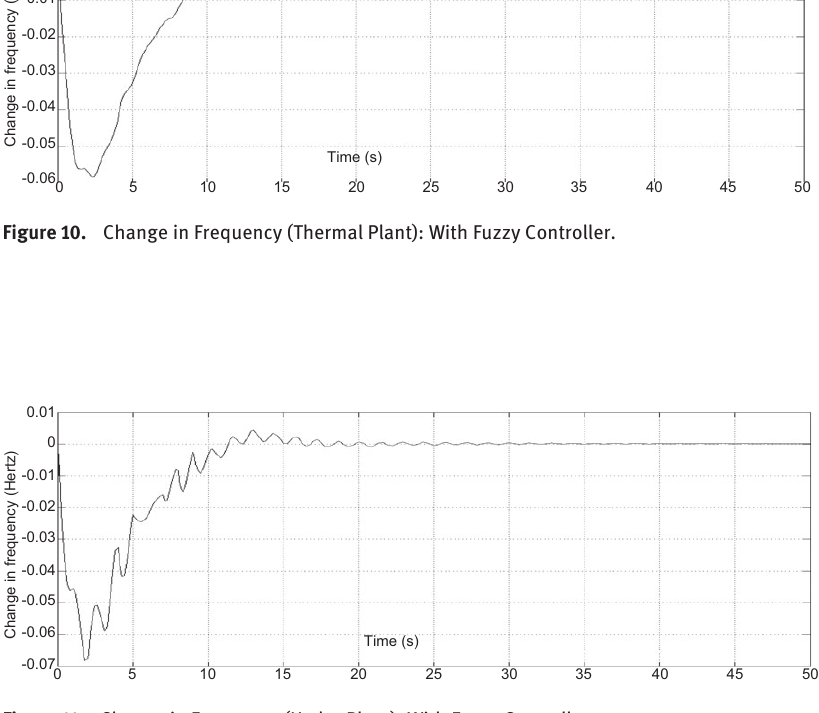
Figure 11. Change in Frequency (Hydro Plant): With Fuzzy Controller.